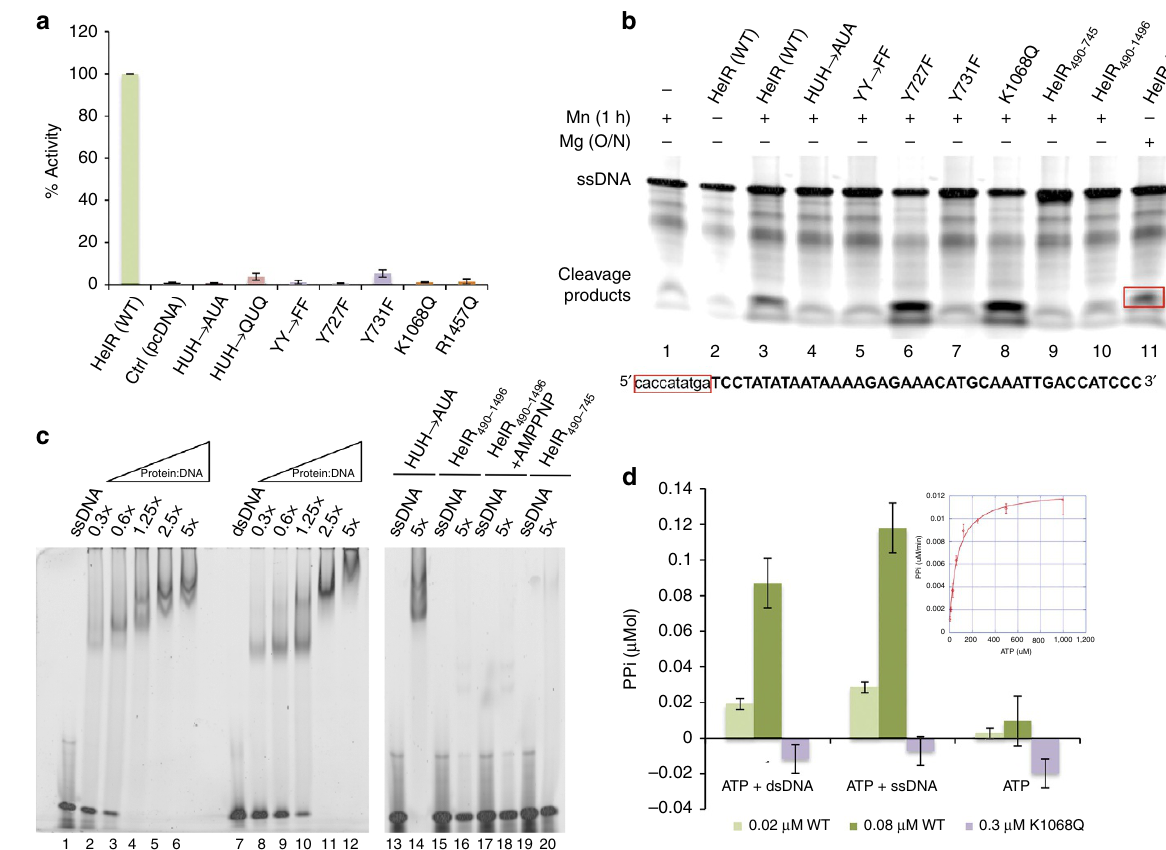
Figure 2 | Functional analysis of the HUH nuclease and SF1B helicase domains. ( a ) Transposition by wild-type (WT) Helraiser transposase and its mutants in HeLa cells. Data are represented as mean ± s.e.m., n ¼ 3 biological replicates. ( b ) Cleavage of single-stranded DNA oligonucleotides by the Helraiser transposase in vitro . ( c ) DNA-binding assay with the Helraiser transposase and its point mutant and truncated derivatives. 0.3–5 (cid:3) values represent molar ratios of protein to DNA. ( d ) Colorimetric ATPase assay with the WTand K1068Q mutant transposase protein. PPi, pyrophosphate release. Data are represented as mean ± s.d., n ¼ 3 biological